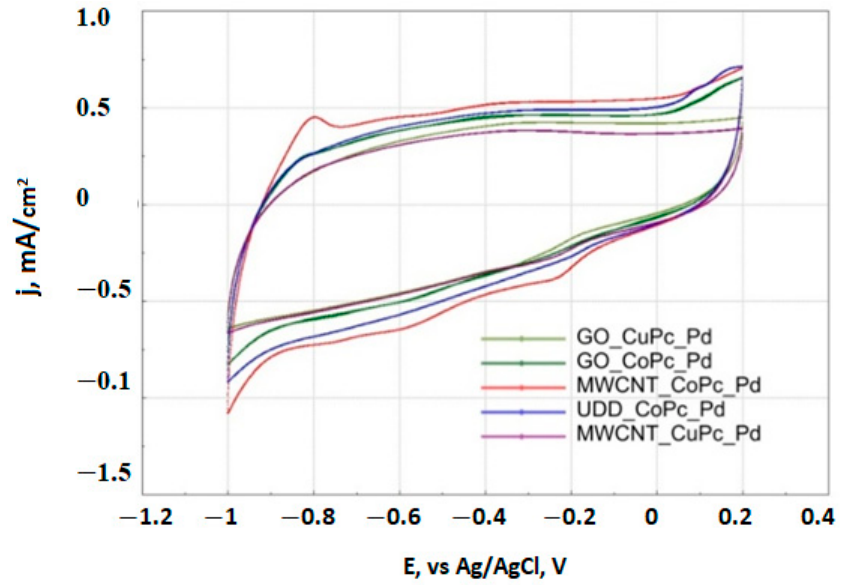
Figure 10. Cyclic voltammogram (CV) on electrode with various catalysts in de-aerated 0.1 M KOH solution: potential scan rate 50 mV · s − 1 .